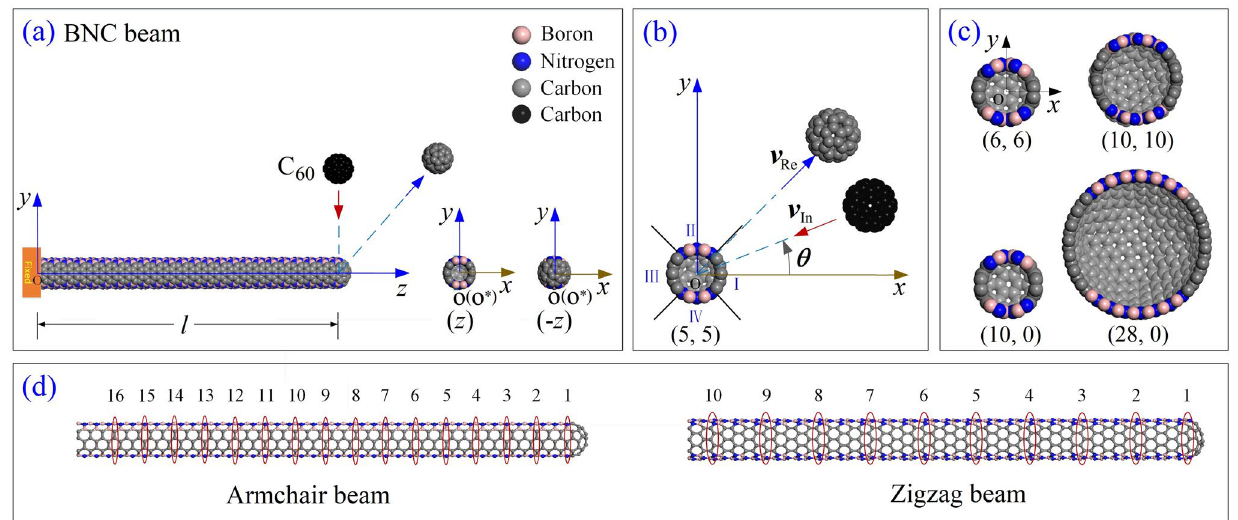
Figure 1. Schematic of a cantilevered beam from a capped BNC nanotube under impact of C 60 at its free end/ cap. ( a ) The beam contains two BN zones (II and IV) and two C zones (I and III). 50% of total atoms in beam are carbon atoms. C 60 moves vertically toward the beam, and is bounced back after collision. ( b ) Incident angle θ is the angle between the moving path and x-axis in the xy-plane. ( c ) The caps of other four beams in tests. ( d ) Selected cross sections of the armchair and zigzag types of beams. The centroid of section 1 is labeled as “o*” with coordinates of ( x o * , y o * , z o *